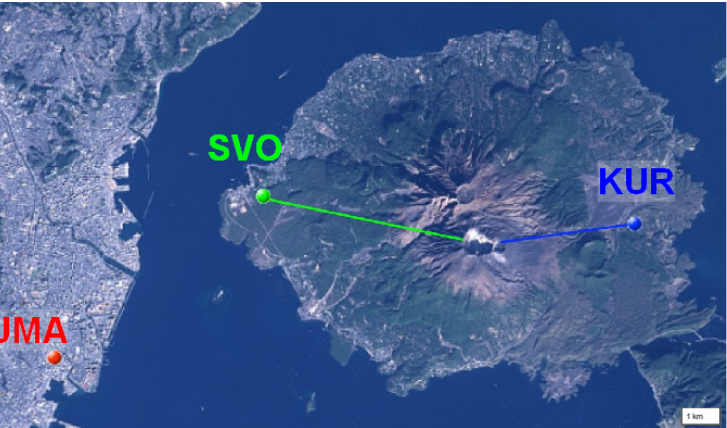
Figure 1. Lidar instruments installed at SVO (green) and KUR (blue). Lines indicate their lines of sight, and the Kagoshima observatory is shown for reference (red). The satellite image was obtained from the Geospatial Information Authority of Japan (https://maps.gsi.go.jp/vector/, accessed on 25 January